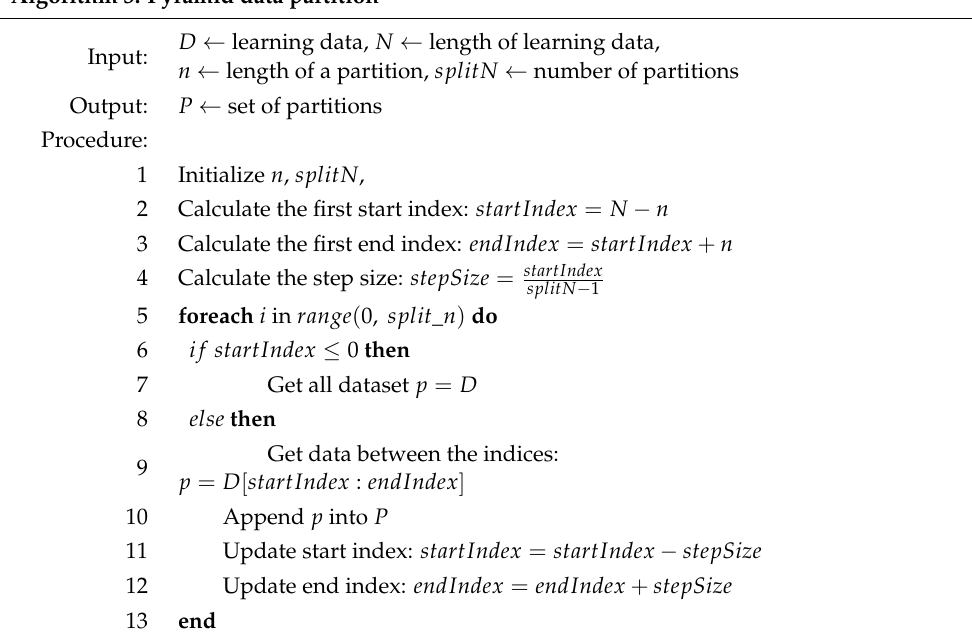
Algorithm 3. Pyramid data partition